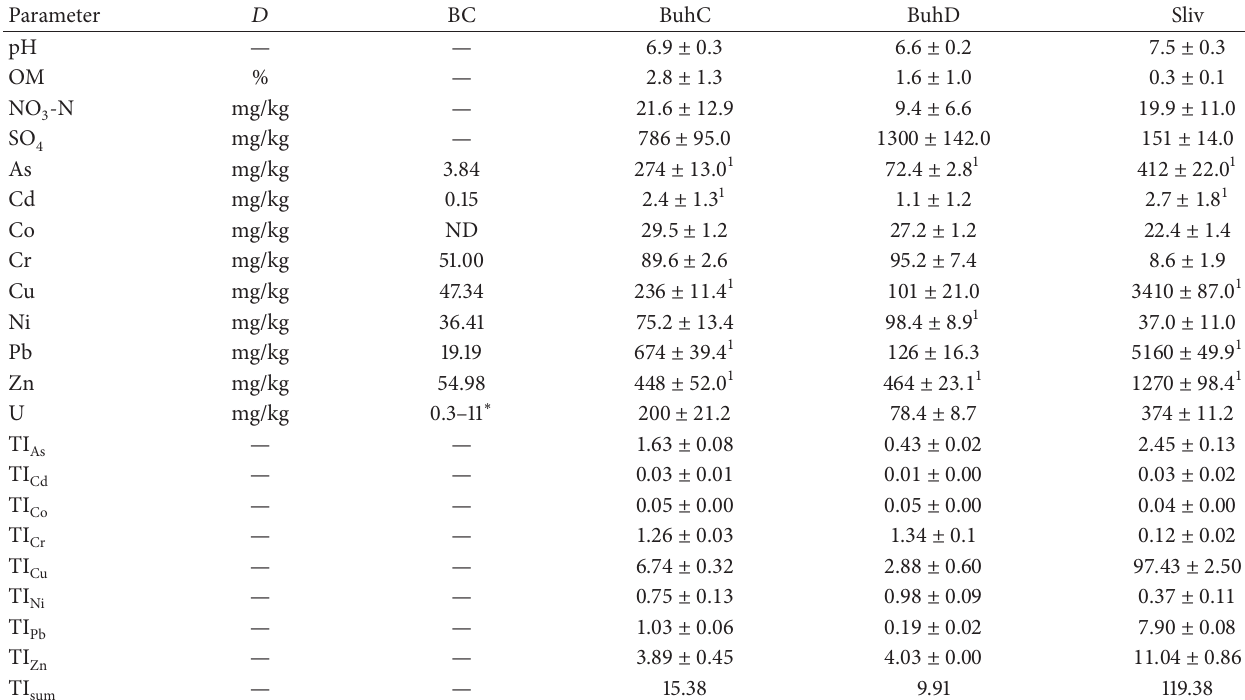
Table 1: Physicochemical characteristics of samples from three sites in Bulgaria polluted by uranium mining activities, expressed as means ± standard deviation ( 𝑛 = 15 ).